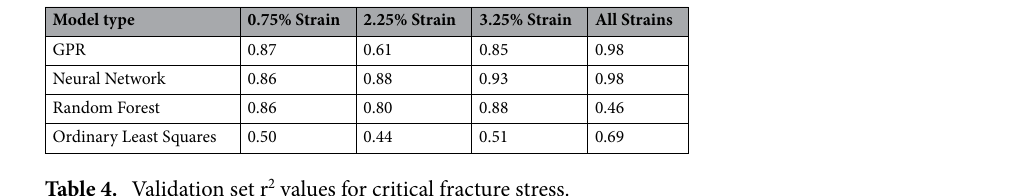
Table 4. Validation set r 2 values for critical fracture